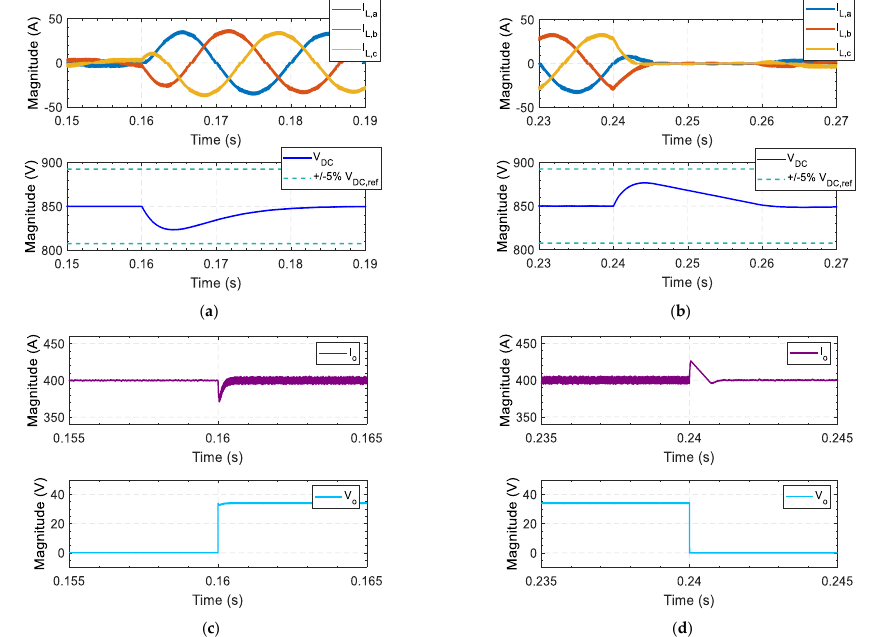
Figure 15. Grid current, DC voltage bus and output physical quantities waveforms during ( a , c ) transient from short-circuit to on load and during ( b , d) transient from on load to short-circuit.